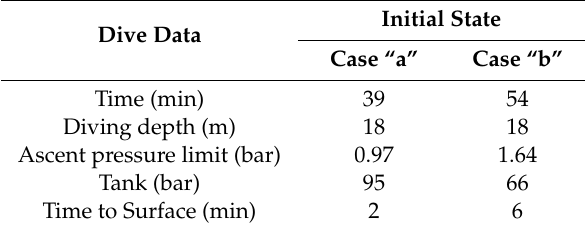
Figure 8. The path suggested by the algorithm changes over time. Table 4. The dive data associated with the two cases presented in Figure